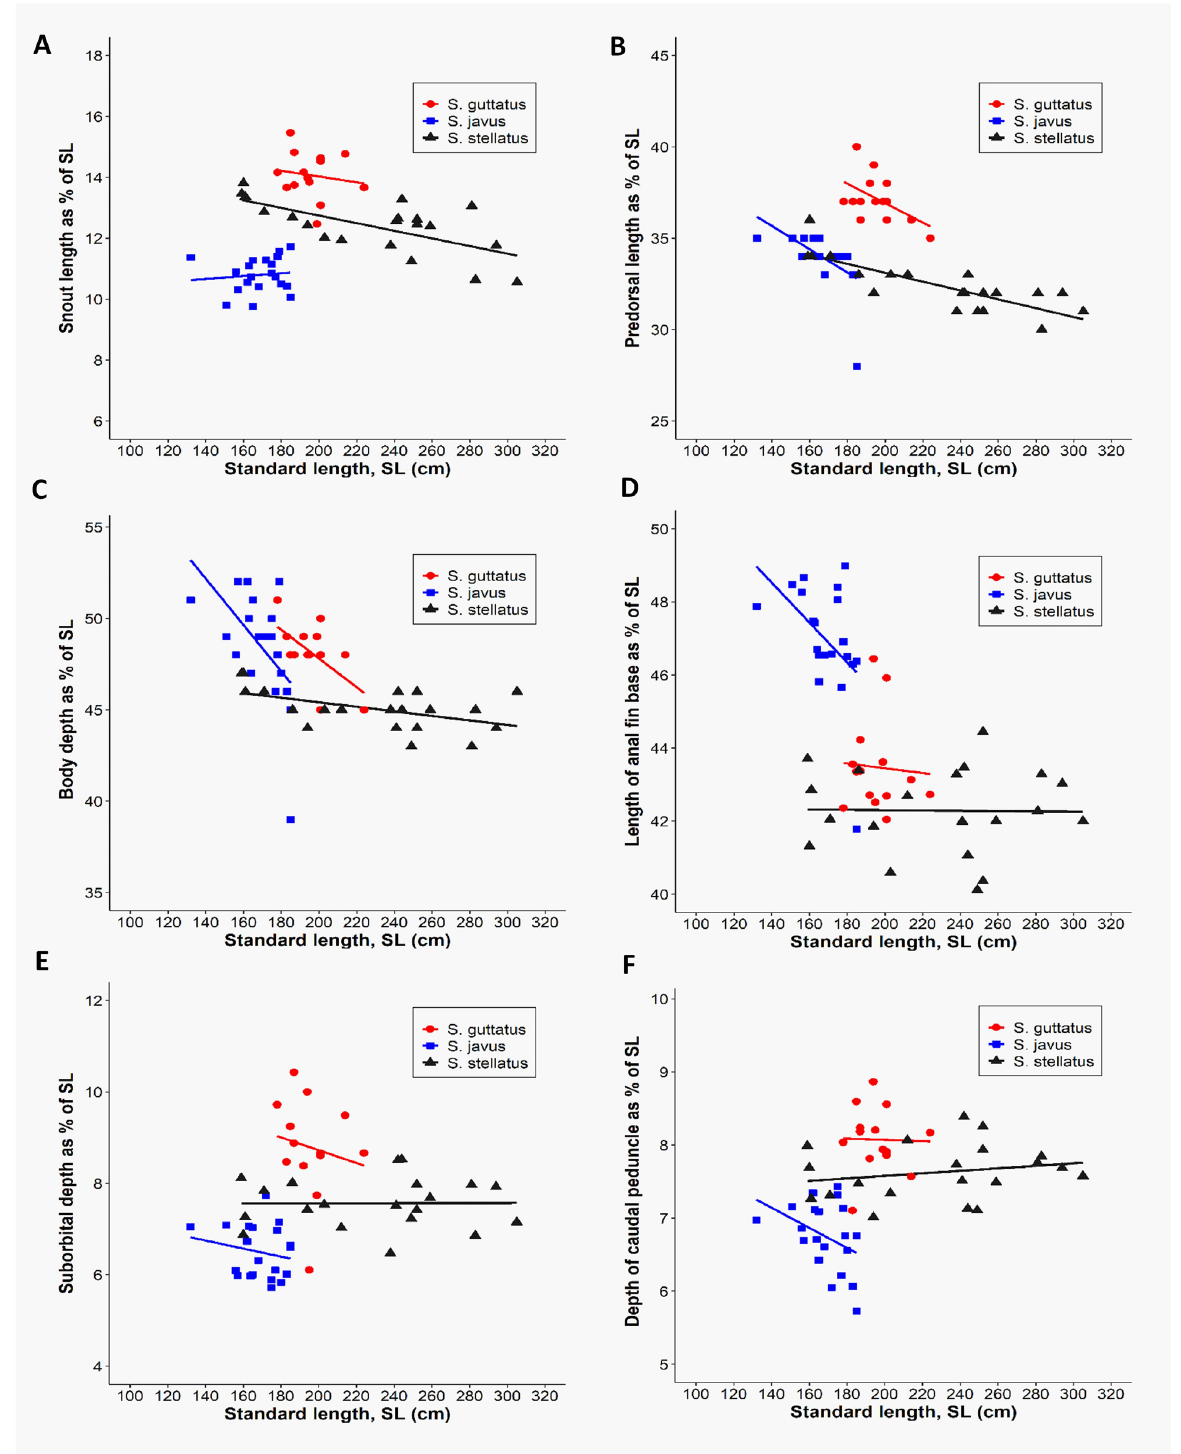
Figure 4. Discrimination of three deep-bodied siganid species [ S. guttatus ( n = 14), S. javus ( n = 20), and S. stellatus ( n = 20)] based on the six morphometric variables relative to the standard length of each species. ( A ) Relationship between snout lengths as a function of standard length. ( B ) Relationship between predorsal lengths as a function of standard length. ( C ) Relationship between body depths as a function of standard length. ( D ) Relationship between lengths of anal fin base as a function of standard length. ( E ) Relationship between suborbital depths as a function of standard length. ( F ) Relationship between depths of caudal peduncle as a function of standard length.